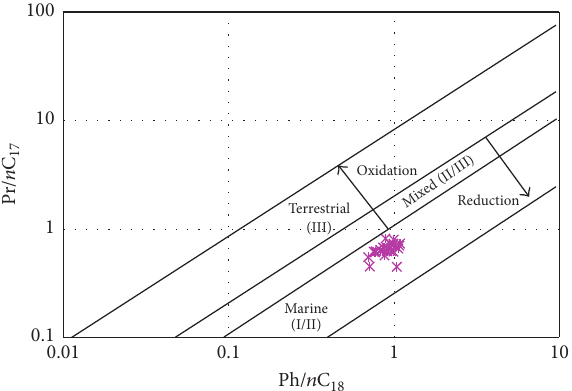
Figure 6: Pr/ n C 17 and Ph/ n C 18 correlation